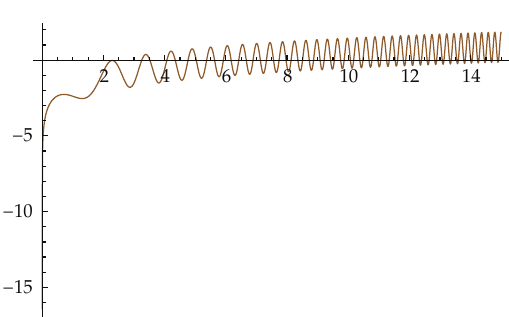
Figure 1: The plot of the function f (cid:2) x (cid:3) including the zeros.